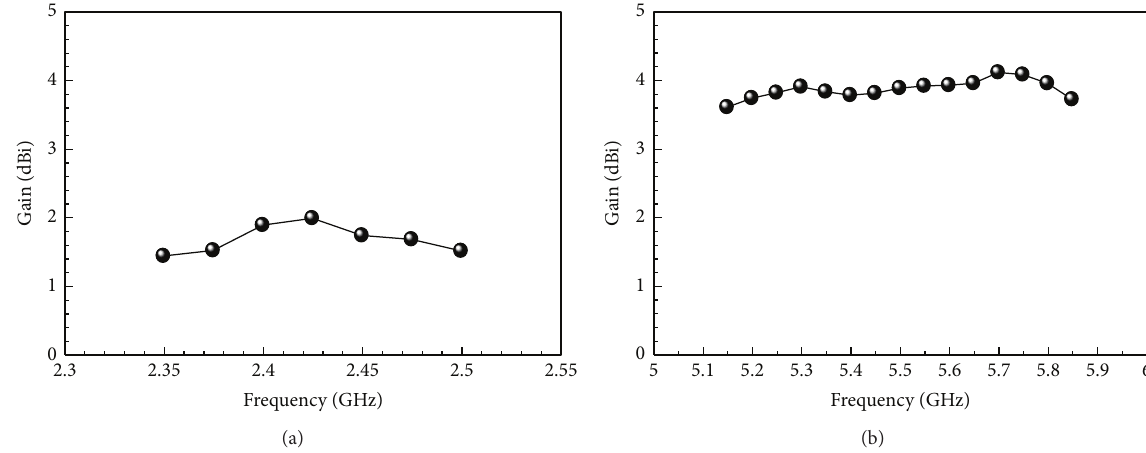
Figure 5: Measured antenna peak gain values versus frequency at (a) 2.35–2.5 and (b) 5.15–5.85 GHz of proposed dual-band antenna.